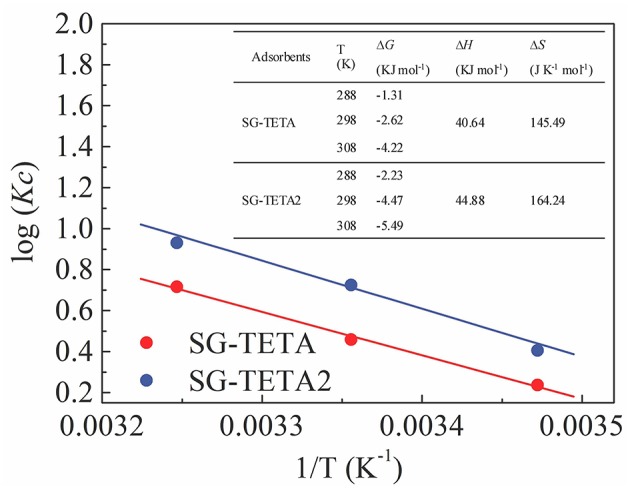
logKc vs. 1/T plots and thermodynamic parameters for Au(III) adsorption on SG-TETA and SG-TETA2.